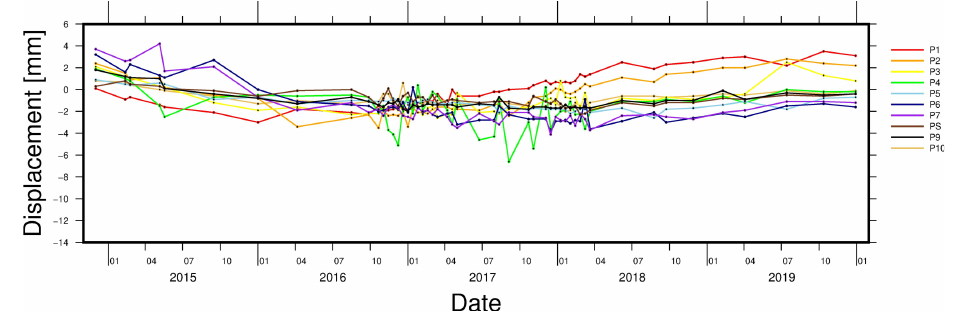
Figure 11. LOS displacements in the 2014–2019